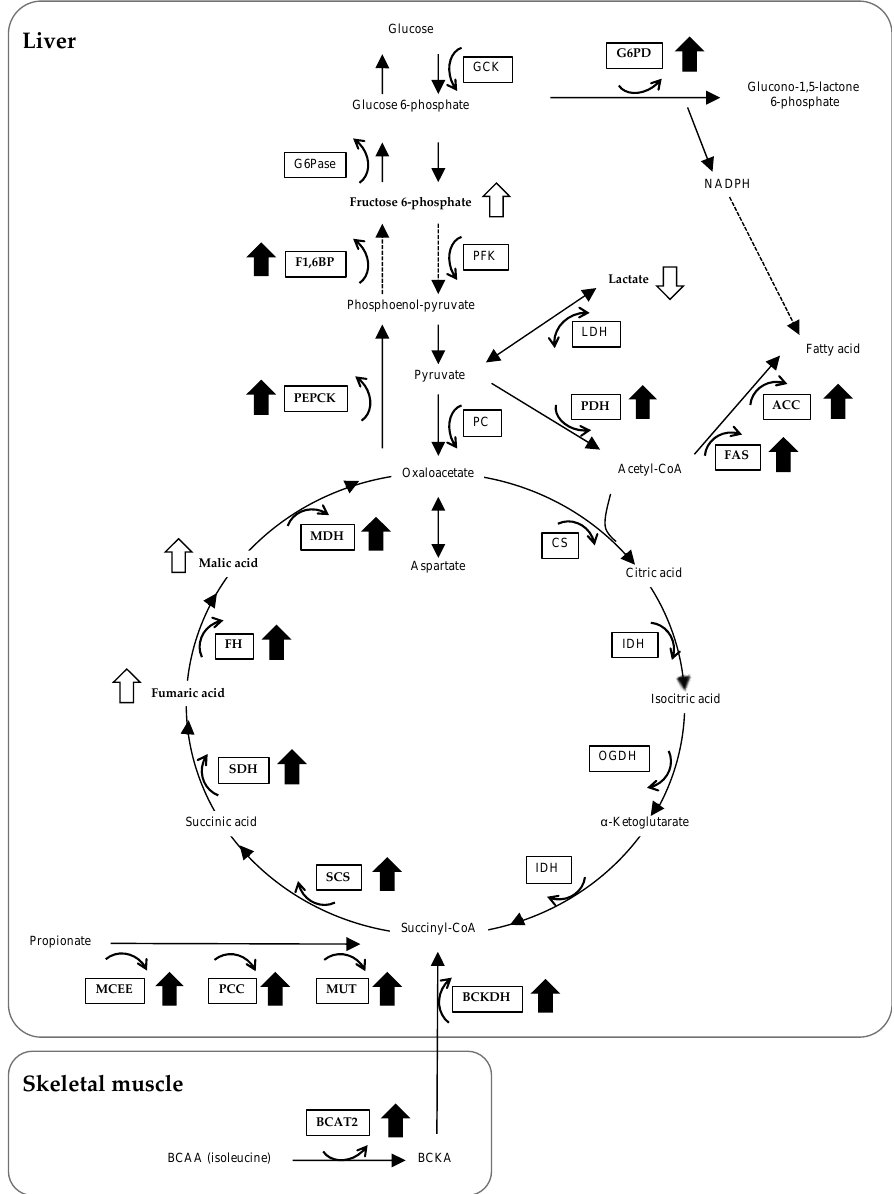
Figure 3. Integrated overview of the metabolic changes induced by feeding the OBFR diet. Open arrows indicate changes in the metabolites in the liver, and closed arrows indicate changes in gene expression in the liver. The metabolic scheme is based on information gathered from the KEGG PATHWAY Database (http://www.genome.jp/kegg/pathway.html). OBFR, outer bran fraction of rice; GCK, glukokinase; PFK, phosphofructokinase; PC, pyruvate carboxylase; PFH, pyruvate dehydrogenase complex; LDH, lactate dehydrogenase; G6PD, glucose-6-phosphate dehydrogenase; CS, citrate synthase; isocitrate dehydrogenase 3α; OGDH, oxoglutarate dehydrogenase; SCS, succinyl-CoA synthetase; SDH, succinate dehydrogenase B; FH, fumarate hydratase; MDH, Mmlate